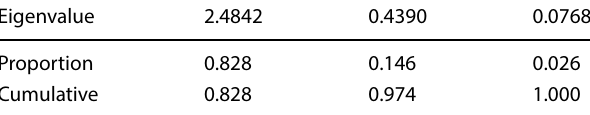
Table 5 Eigen analysis of the correlation